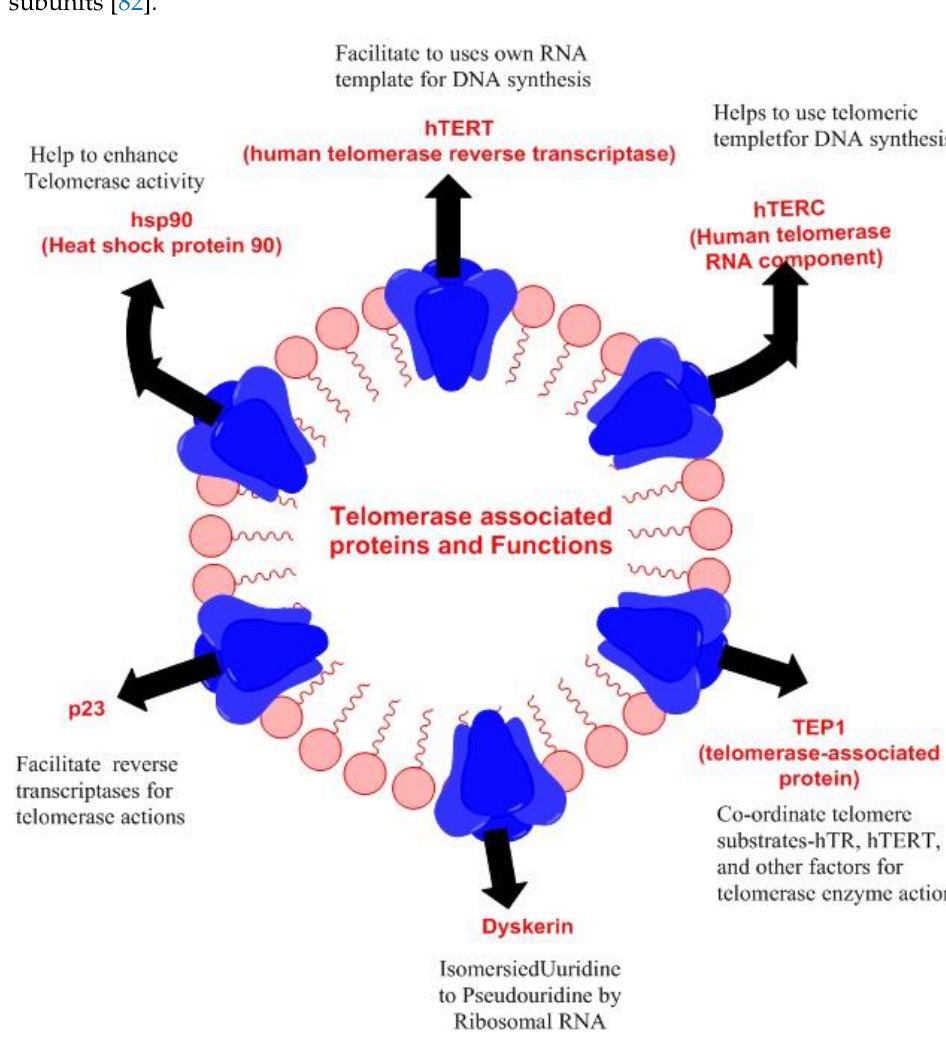
Figure 11. Telomerase proteins and their functions .